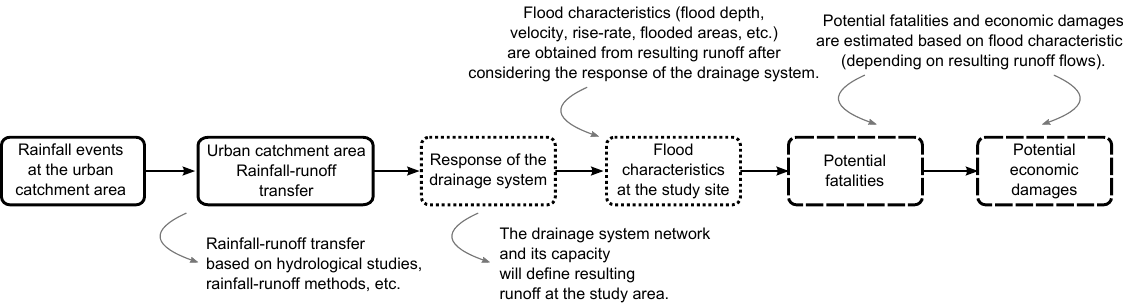
Fig. 2. Generic influence diagram: independent initiating event (Scheme A1). Note: nodes outlined with solid, dotted and dashed lines refer to loads, system response and consequences, respectively.